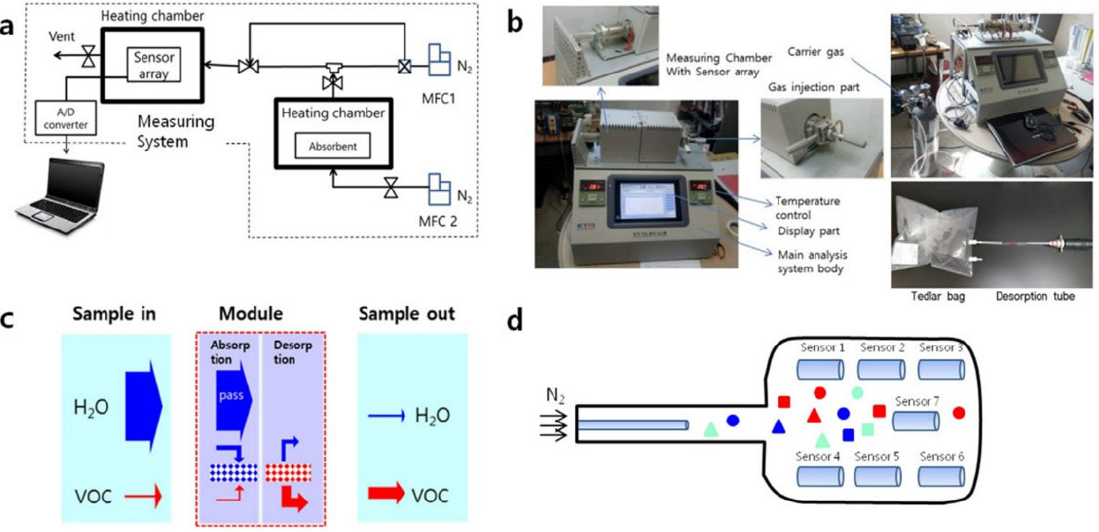
Figure 5. ( a ) Schematic of measurement system of exhaled breath analysis, ( b ) complete system pho ‐ tographs, ( c ) porous material based on 2,6 ‐ diphenylene oxide polymer is filled inside the desorption tubes, ( d ) and a delivery unit Reprinted with permission from [91] Copyright 2018 Elsevier.